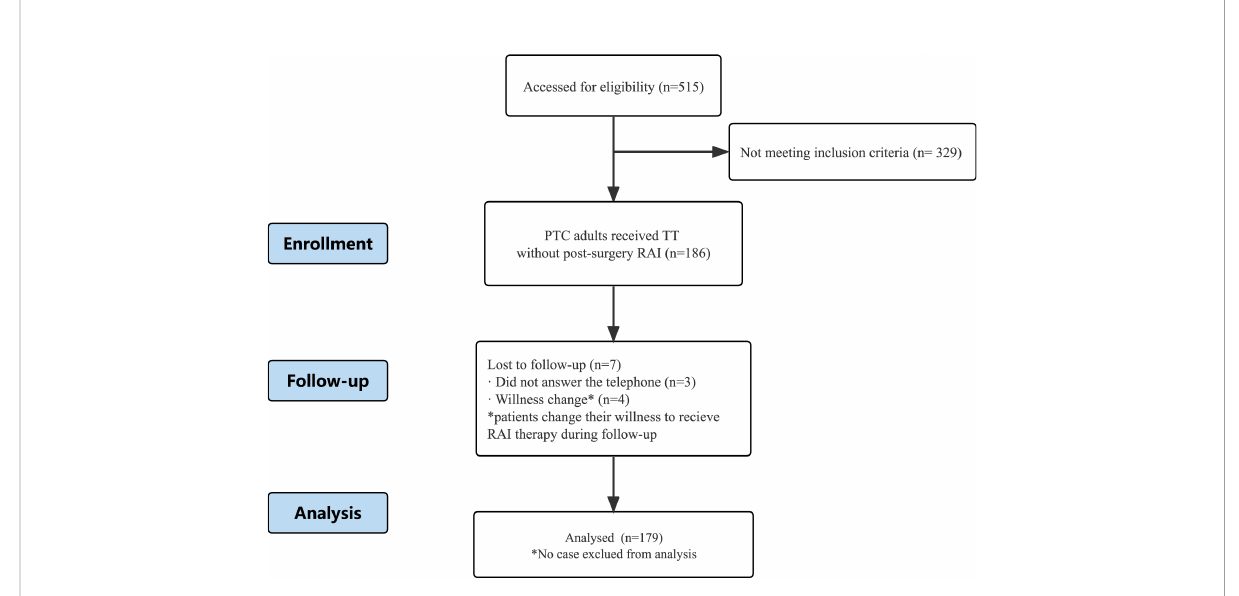
FIGURE 1 Flow diagram for inclusion and follow-up of this